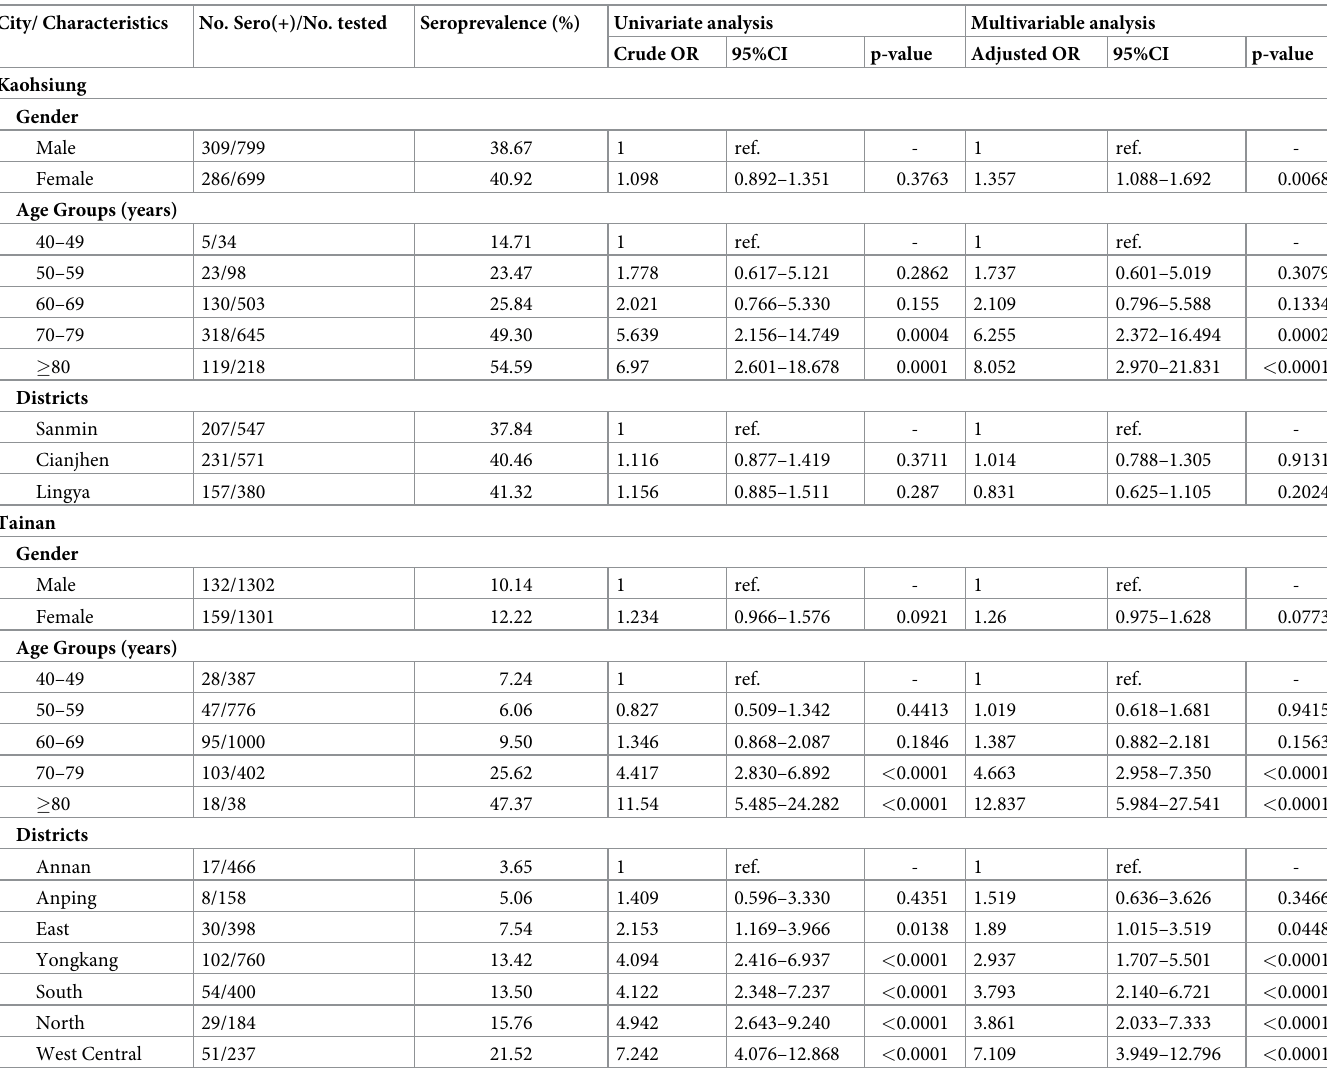
Table 2. Univariate and multivariable analyses of past DENV infection among study subjects in in Kaohsiung City and Tainan City in 2016. City/ Characteristics No. Sero(+)/No.